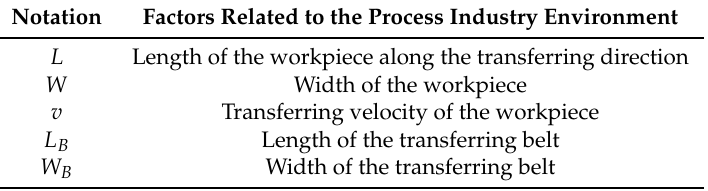
Figure 2. Schematic illustration of the industrial wireless sensor network (IWSN) for process parameter estimation. Table 1. Factors of the process industry scenario related to IWSN